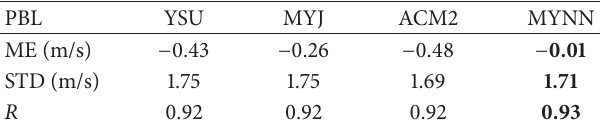
Table 9: For March 2005, statistical metrics (ME in m/s, STD of the ME in m/s, and 𝑅 ) for wind speed [averaged over all the heights: 30 to 100m)], so as to evaluate the performance of four PBL schemes (YSU, MYJ, ACM2, and MYNN) in the WRF